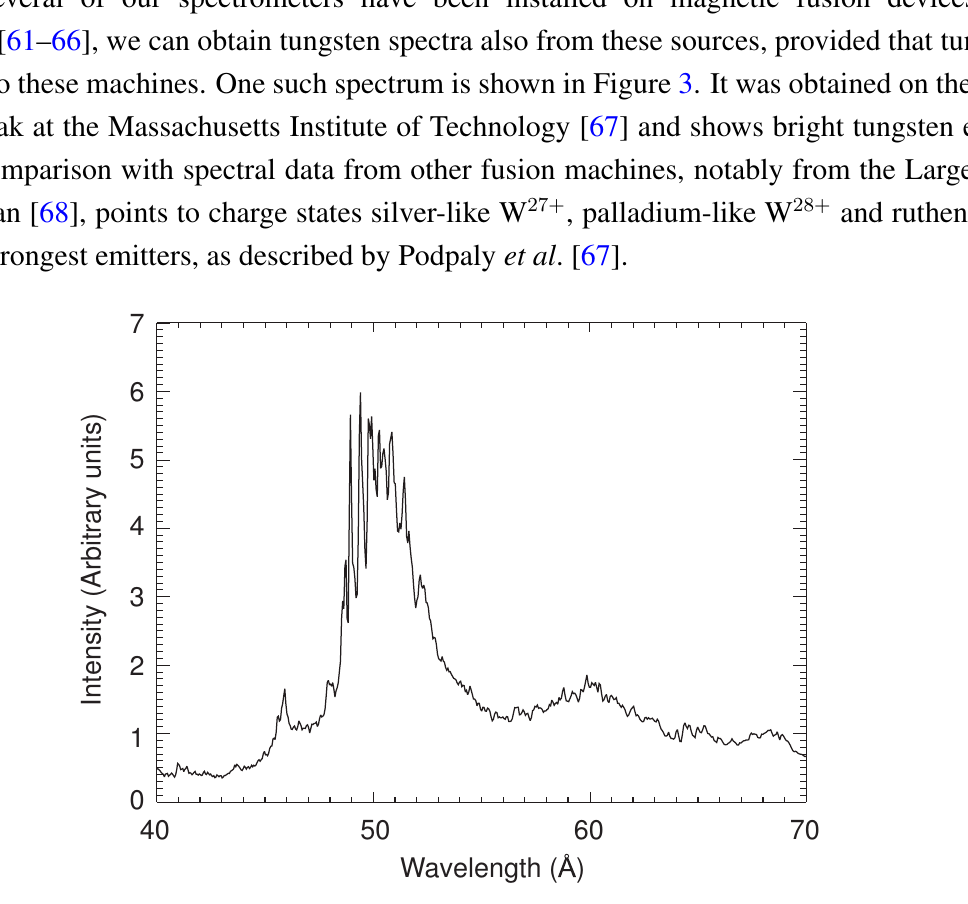
Figure 3. Emission from tungsten ions observed on the Alcator C-mod